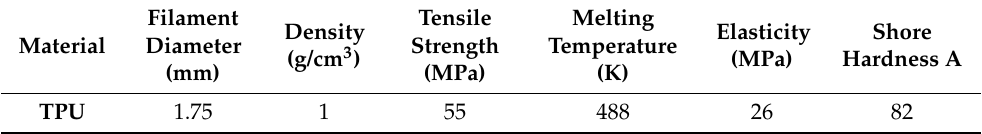
Table 1. Main mechanical and physical properties of TPU, provided by Recreus.